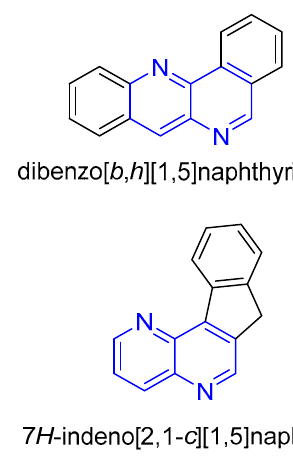
Figure 2. Examples of fused 1,5-naphthyridines with carbocycles.